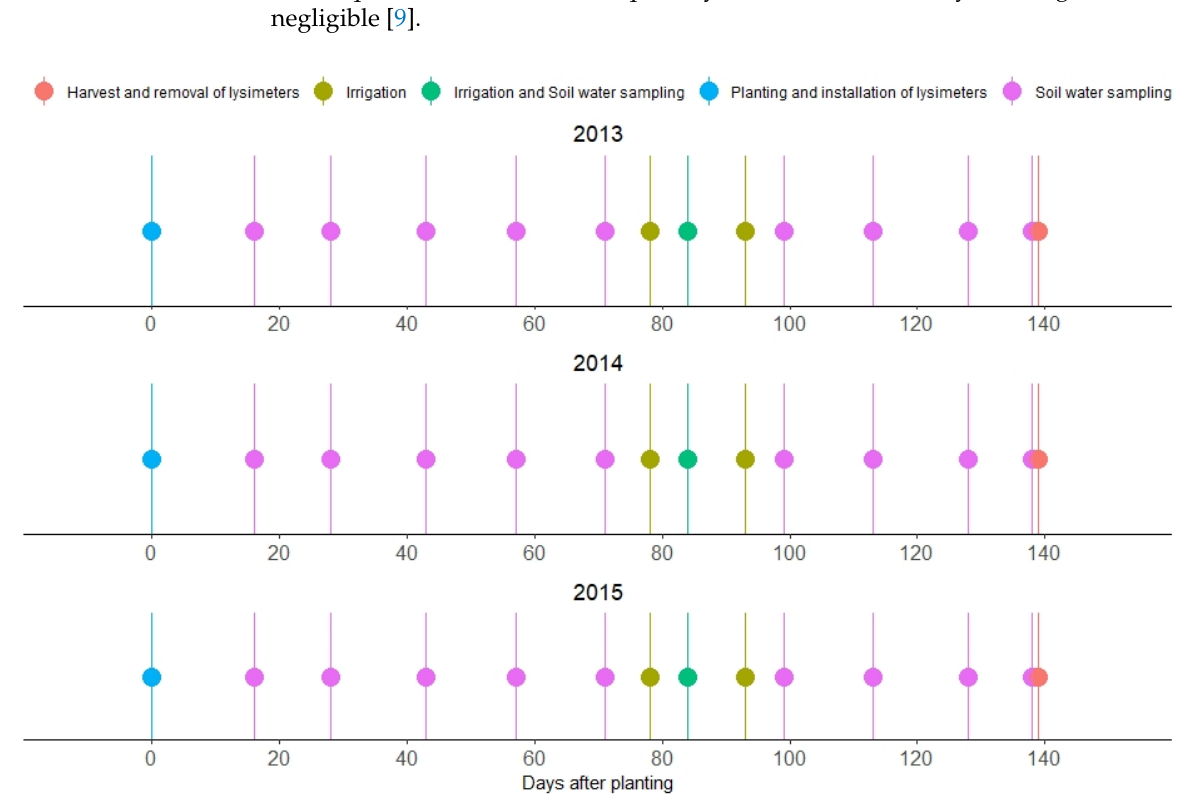
Figure 1. The schedule of irrigation and soil water sampling in the irrigated site in 2013–2015. Soil water samples were collected at the same time in the non-irrigated site.